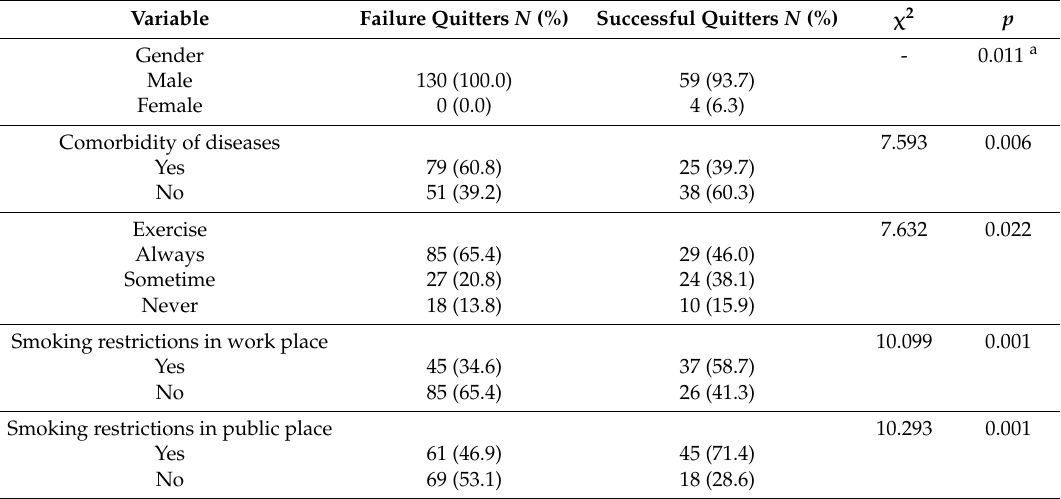
Table 4. Factors significantly associated with success in quitting smoking.